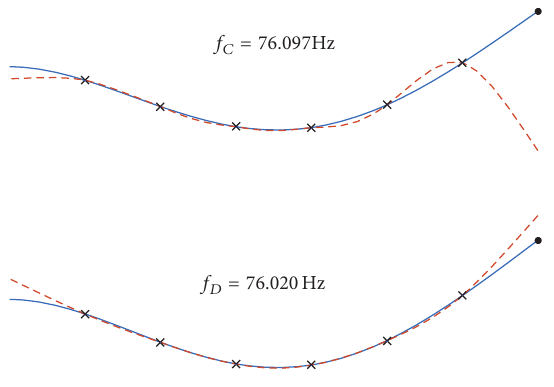
Figure 14: Mode shapes at points 𝐶 and 𝐷